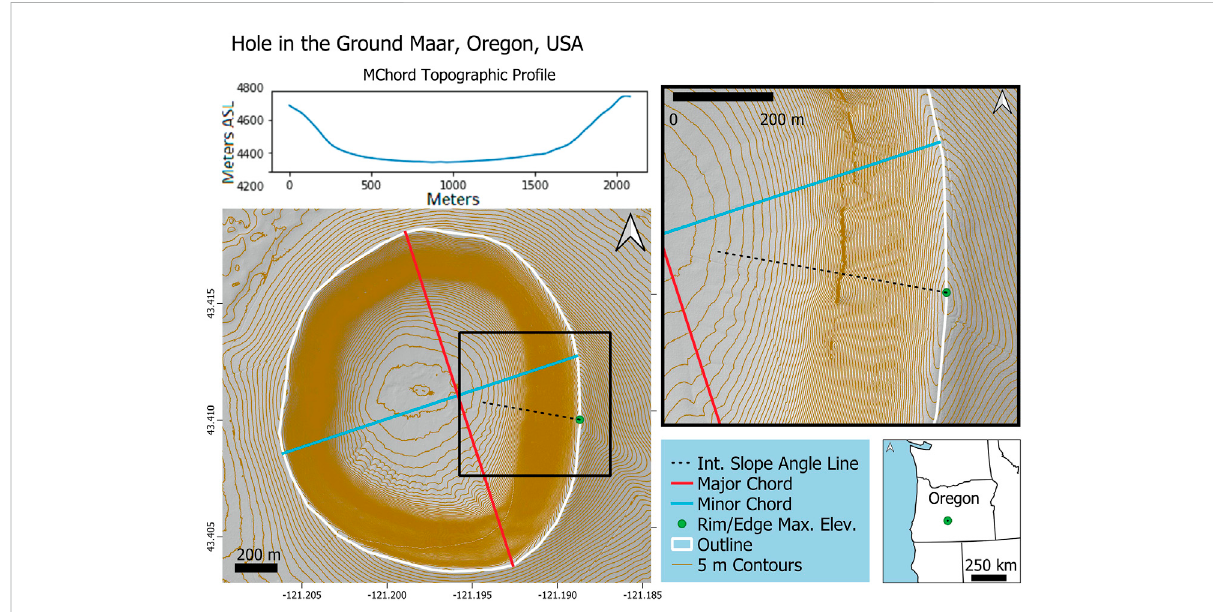
FIGURE 8 DEM-derived hillshade mapofHoleintheGroundmaar,Oregon,UnitedStates.Theinteriorslopeangle ofHoleintheGround isthehighestfor maars in SMILES at 47.7 ° , 7.5 ° higher than the next highest interior slope angle maar. Shown here with 5 m DEM-derived contour lines, the resistant pre-eruptive layers produce locally higher slope